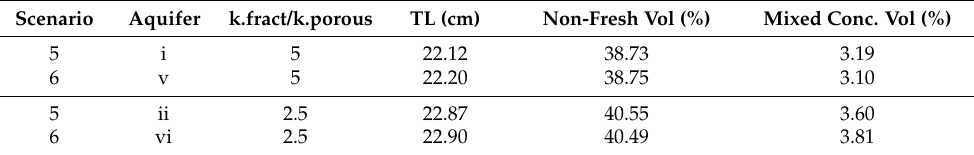
Table 4. SWI intrusion characteristics generated by critical abstraction in numerical aquifers having the same permeability contrast between their discontinuity and the surrounding homogeneous porous